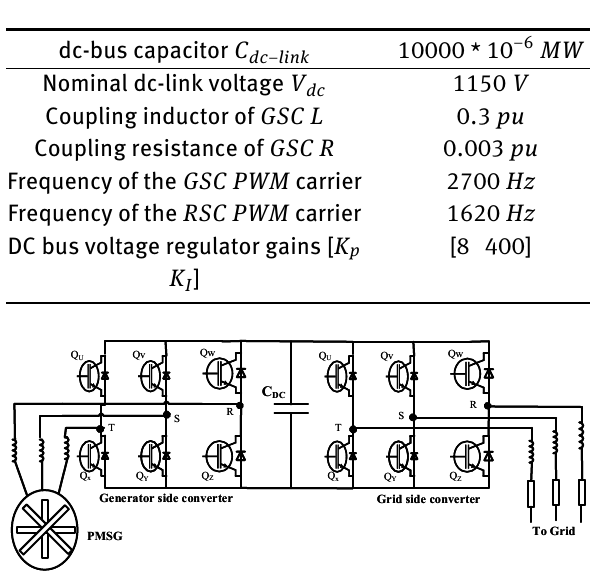
Figure 16: Frequency